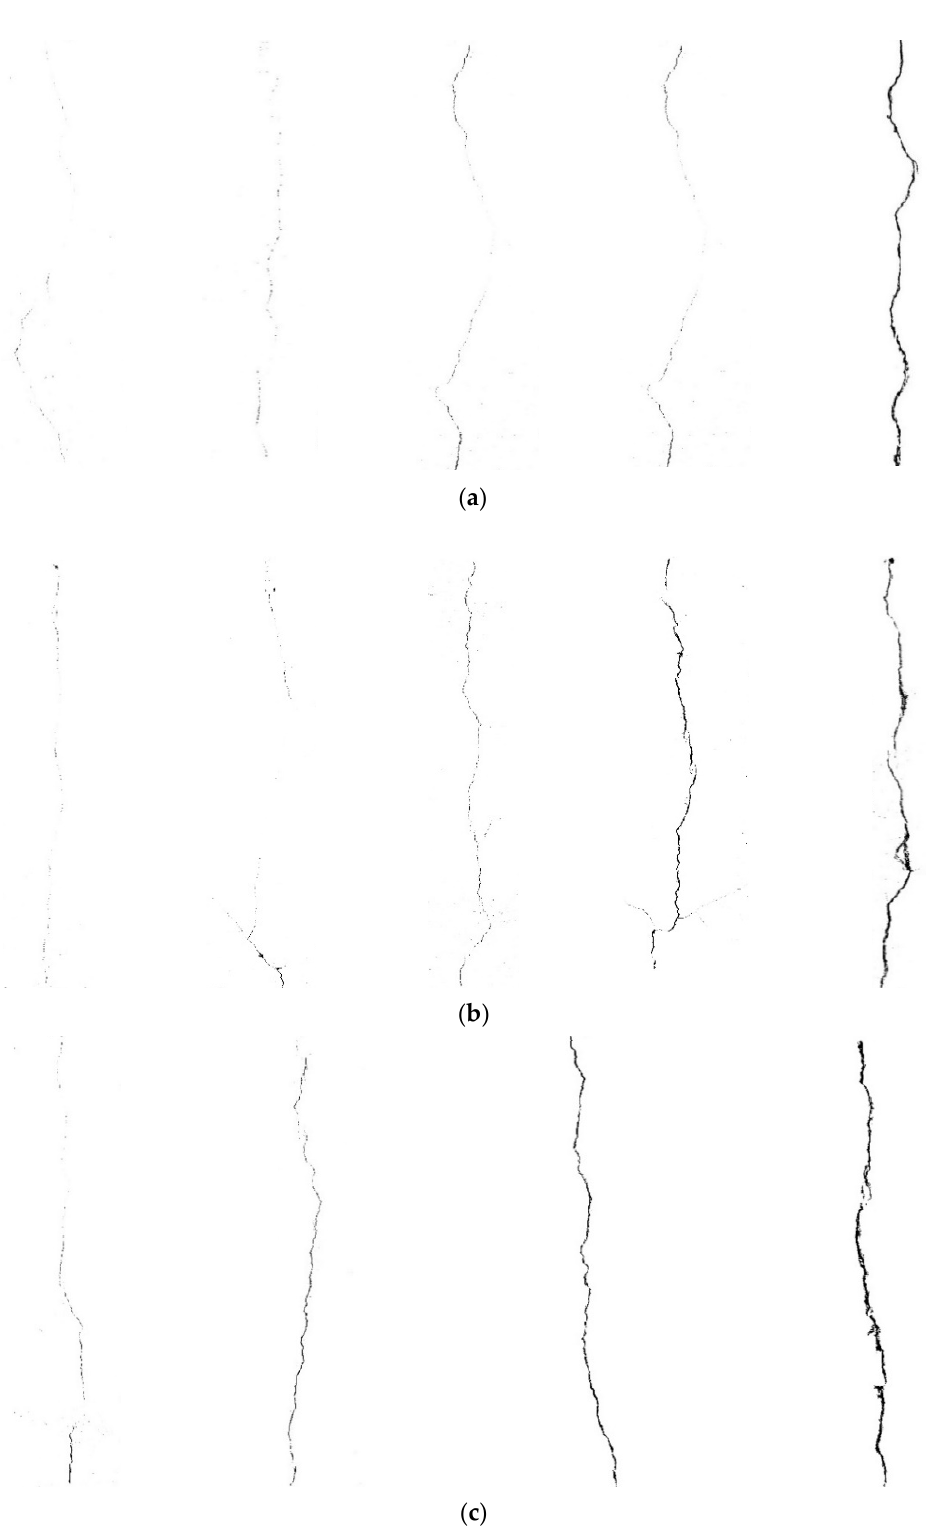
Figure 6. Binary graph of corrosion-induced cracks with different corrosion degrees and steel bar diameters: ( a ) Binary graph of rust expansion crack with d = 6.5 mm; ( b ) Binary graph of rust expansion crack with d = 8 mm; ( c ) Binary graph of rust expansion crack with d = 10 mm. Table 3. Calculation parameters δ and N of fractal dimension.